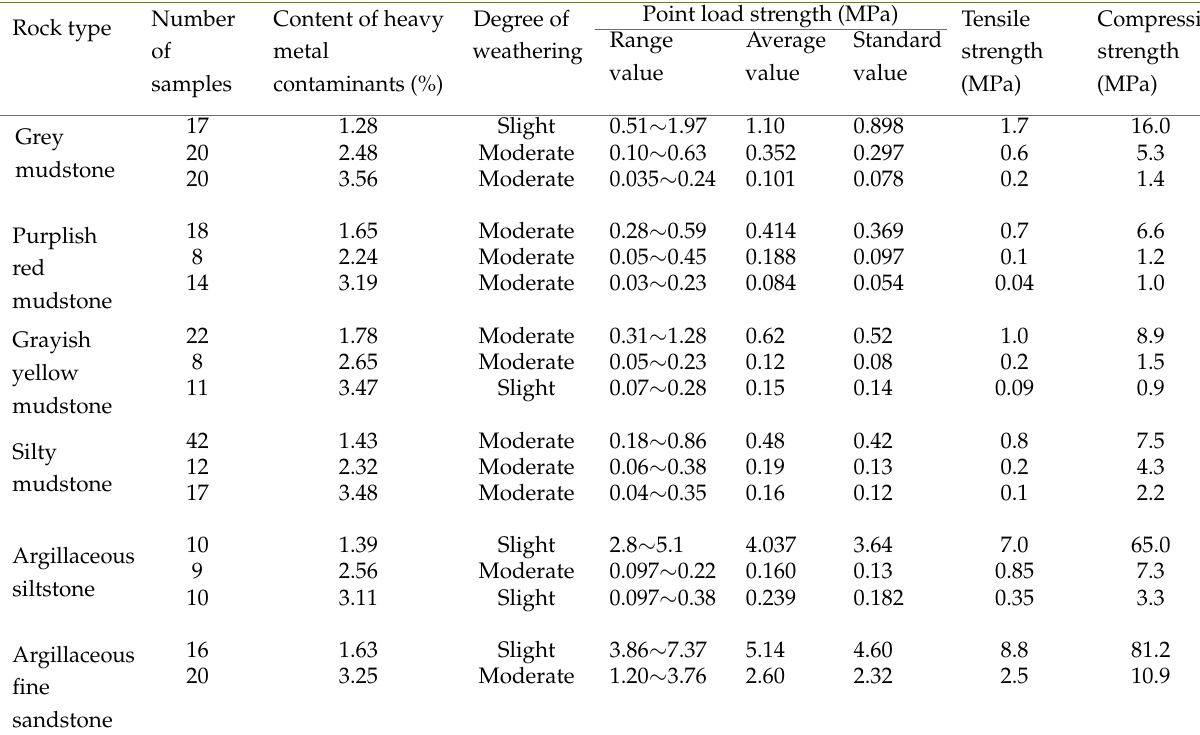
Table 4. The results of point load